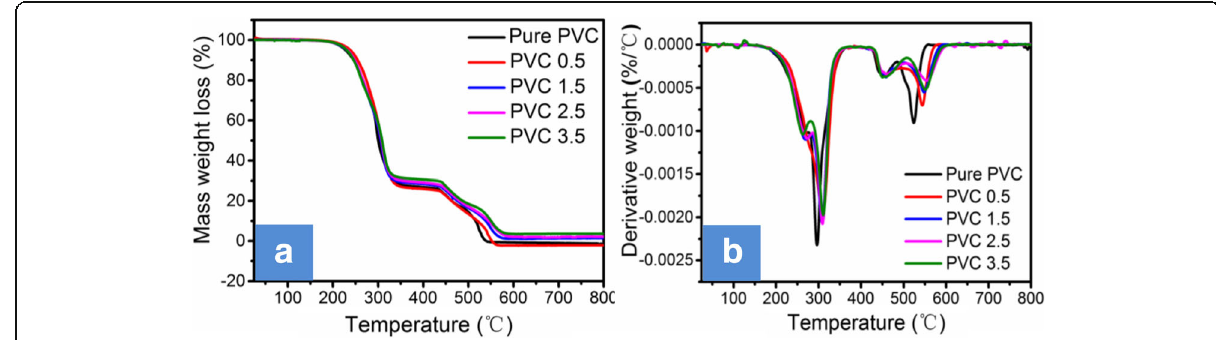
Fig. 4 TGA a and DTG b curves of flexible PVC and PVC-matrix composites in air atmosphere. The thermal stability of the PVC-matrix nanocomposite was improved, which could be ascribed to the synergistic effects between TNTs and GO